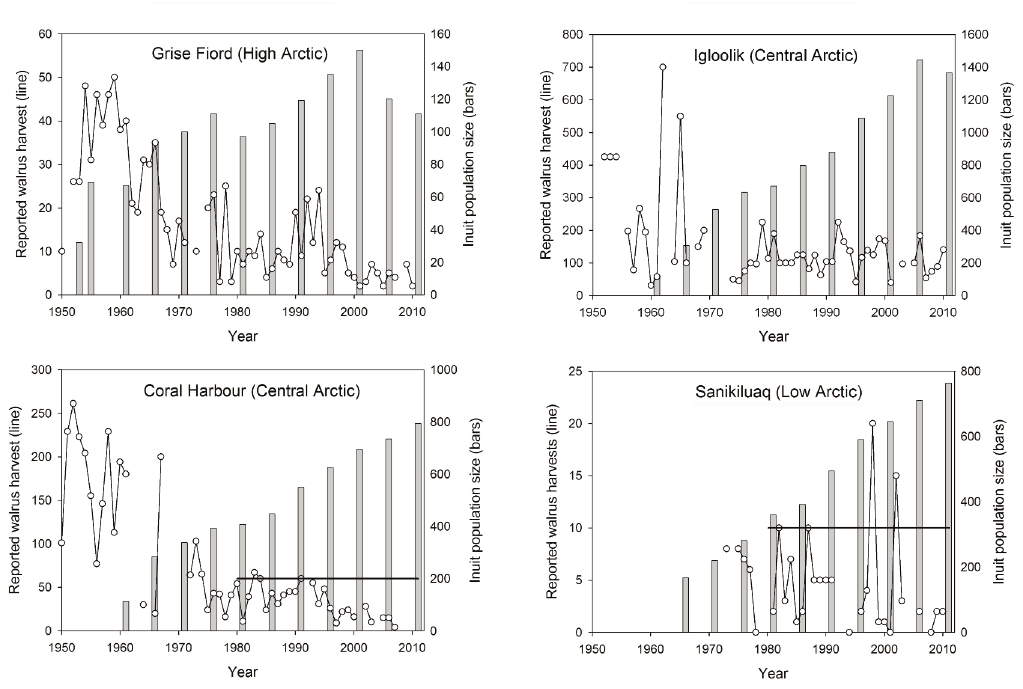
Fig. 16. Comparisons of the annual landed walrus catches and Inuit populations of represen- tative communities in the eastern Canadian Arctic, 1950 to 2011 (catch data: Supplement 4; census data: Marcus 1992, NPC 2008, Statistic Canada 2012).